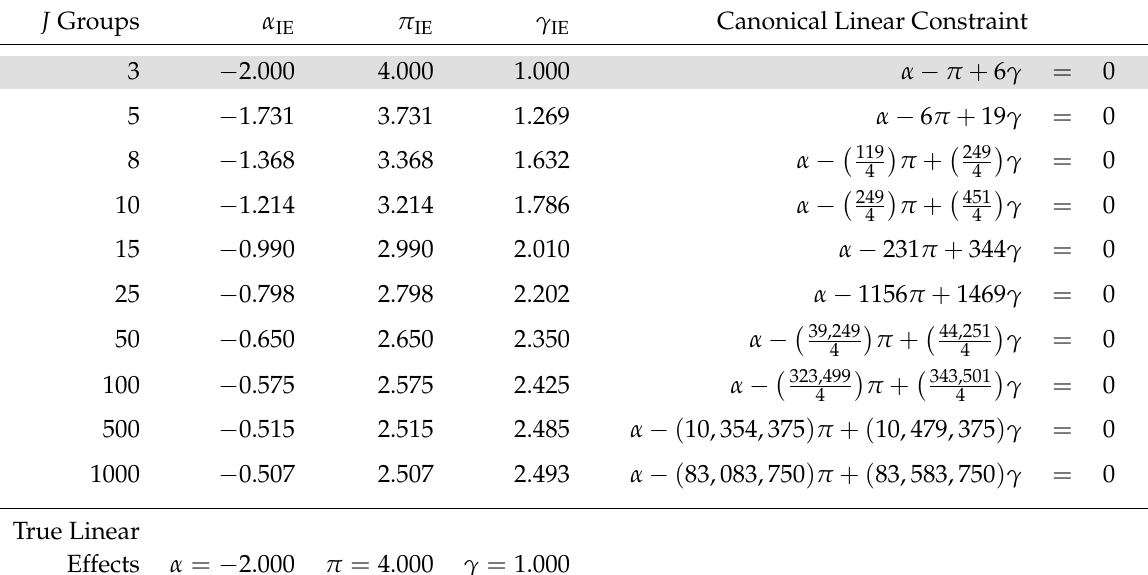
Table 8: Sensitivity of the IE Last to number of period (and cohort) groups. J Groups